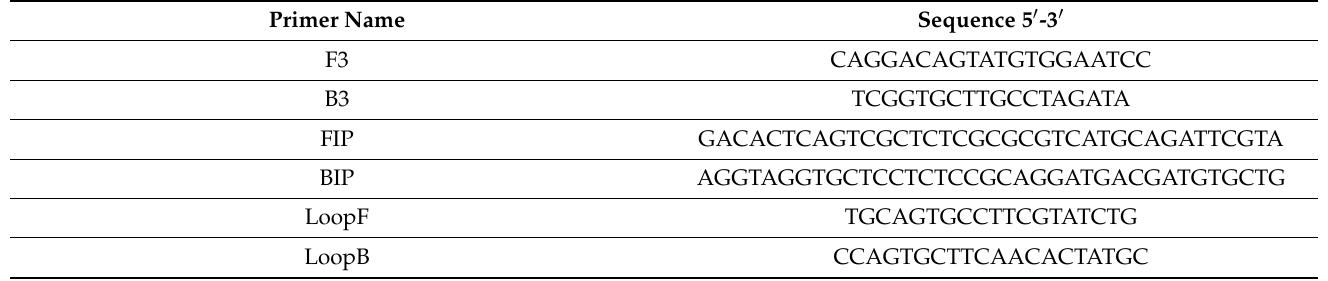
Table 1. LAMP primers specific to the β -tubulin 2 gene of Dothistroma septosporum .